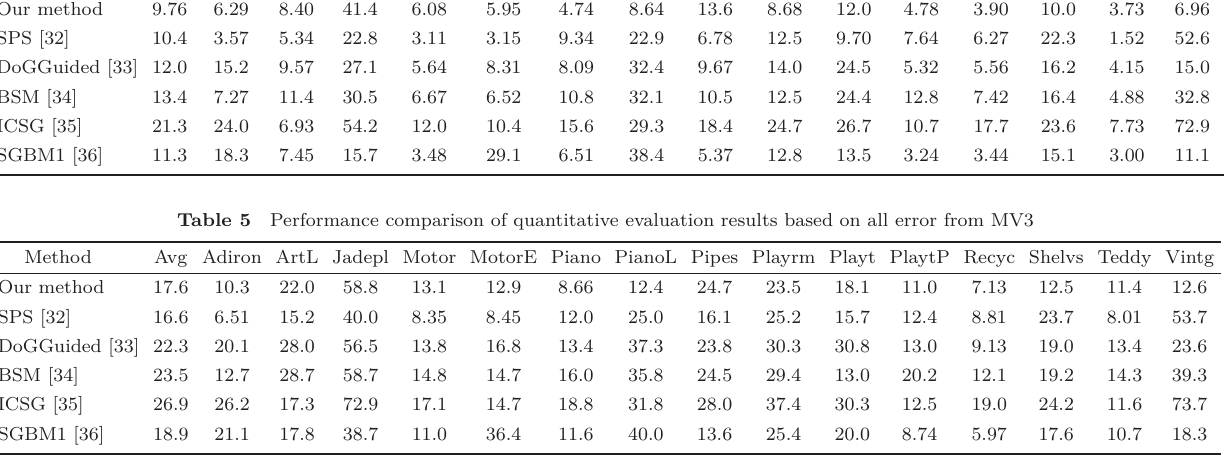
Table 4 Performance comparison of quantitative evaluation results based on nonocc error from MV3 Method